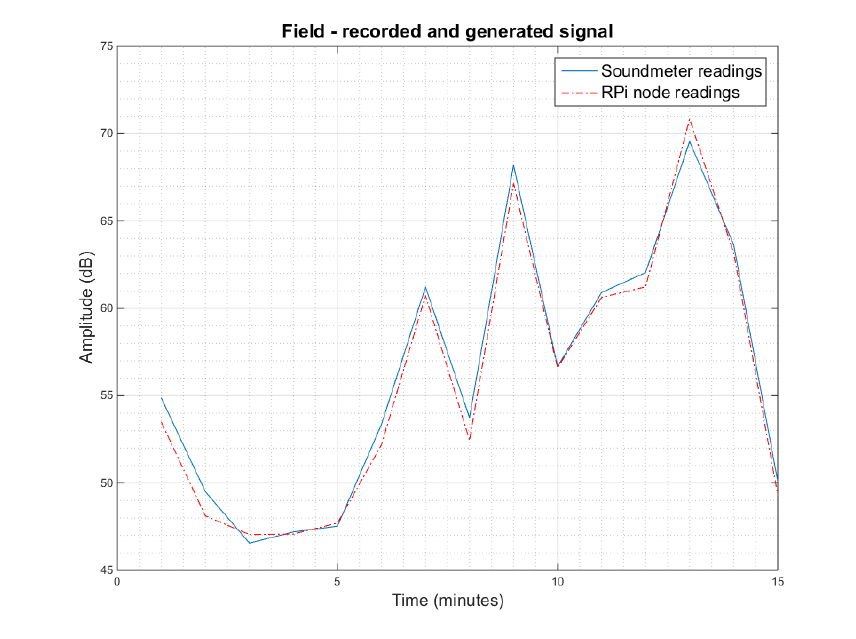
Figure 8. Data obtained from the sound level meter and the Raspberry node in the field test.